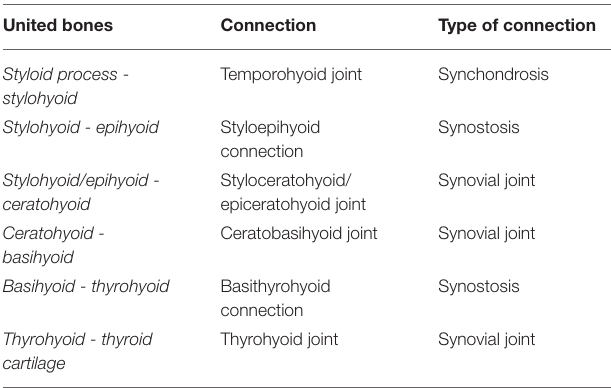
TABLE 1 | Classification of connection between the different parts of the hyoid